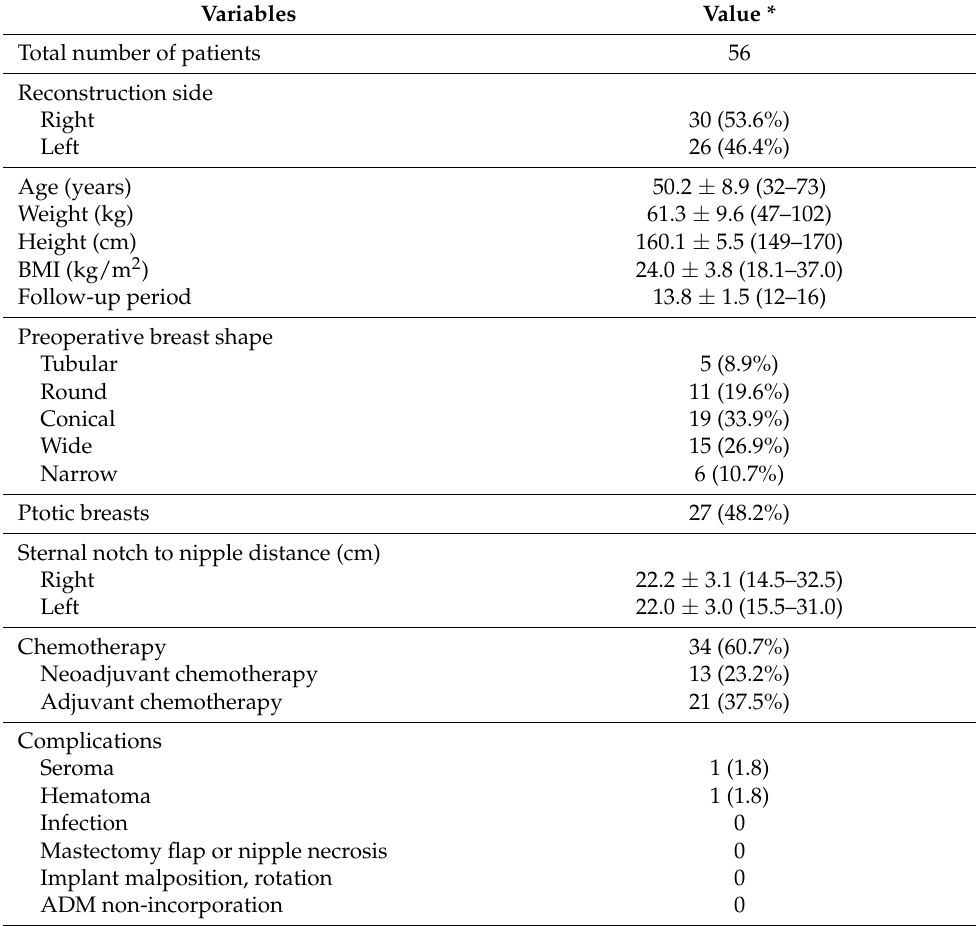
Table 1. Patient baseline characteristics and operative data.